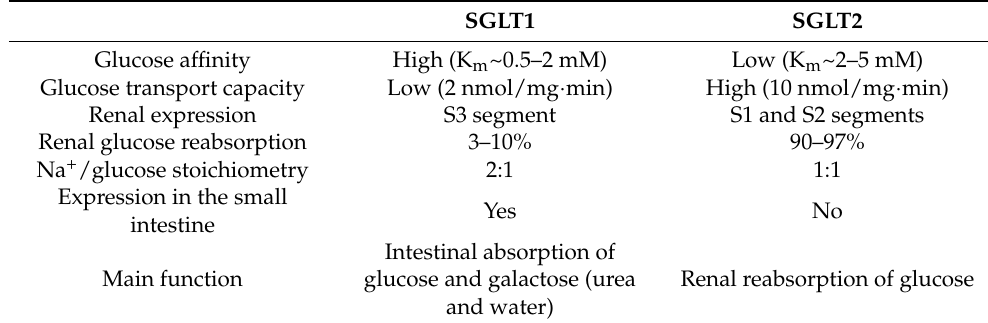
Table 2. Comparison between SGLT1 and SGLT2 co-transporters [42,43].